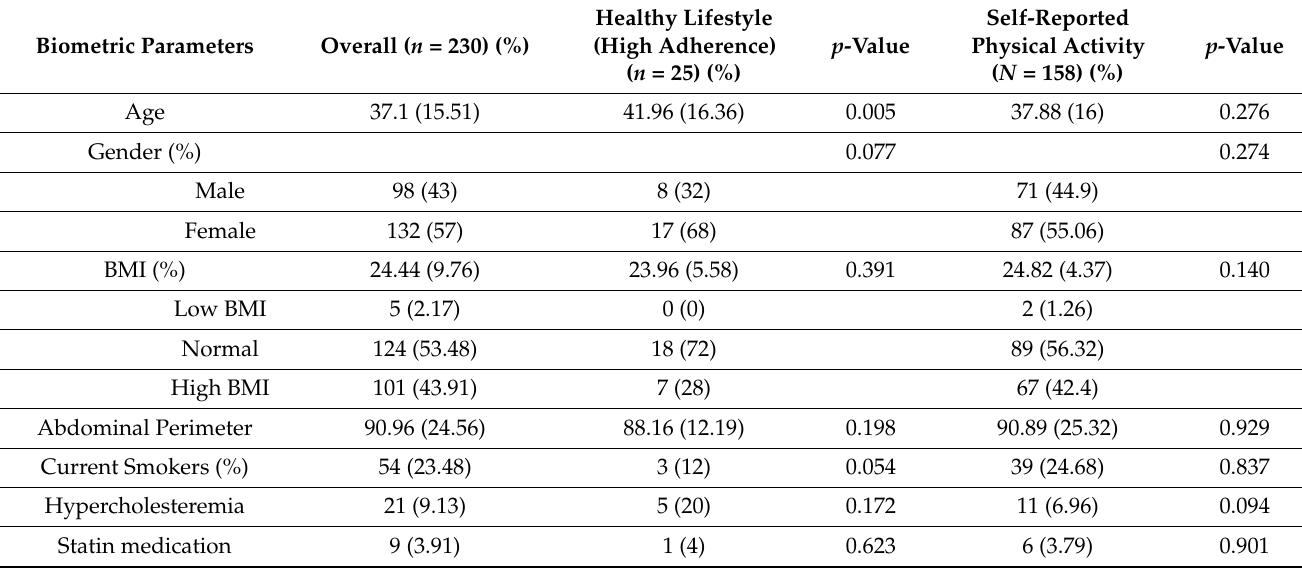
Table 3. Summarized biometric parameters. BMI = Body Mass Index. Data presented as mean (SD) or N (%).